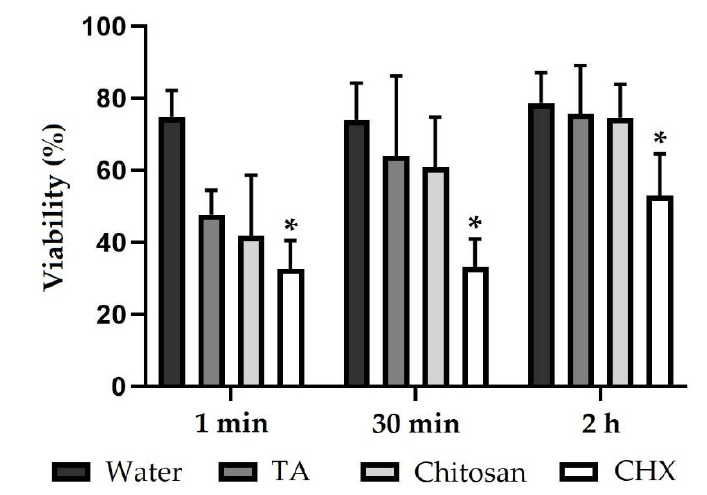
Figure 4. Viability (%) of bacteria in saliva samples. Subjects rinsed with different experimental solutions. Saliva samples were collected 1 min, 30 min and 2 h after rinsing. Saliva bacteria were stained with LIVE/DEAD ® Baclight™, and viability was evaluated using ImageJ software. The height of the bars corresponds to mean values and the line applied to standard deviations. Friedman test followed by Dunn’s multiple comparison test: significant differences ( p < 0.05) to water are marked with *. TA = tannic acid, CHX = chlorhexidine.